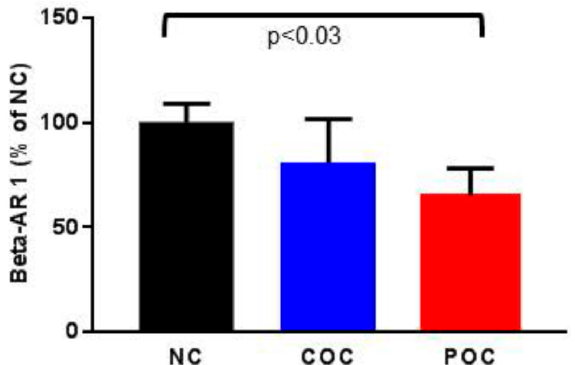
Figure 2. The β -arrestin 1 protein levels (mean ± SEM) in the leukocytes were compared among women using non-hormonal or no contraceptives (NC), estrogen-progestin combination-oral contraceptives (COC), and progestin-only contraceptives (POC). Data are expressed as percentages of values for women in the NC group. The β -arrestin1 (ng/mg) levels were significantly attenuated in women in the POC group, compared to women in the NC group ( p < 0.03). There were no statistically significant differences in the β -AR 1 levels between women in the NC group and those in the COC group, and between women in the COC group and those in the POC